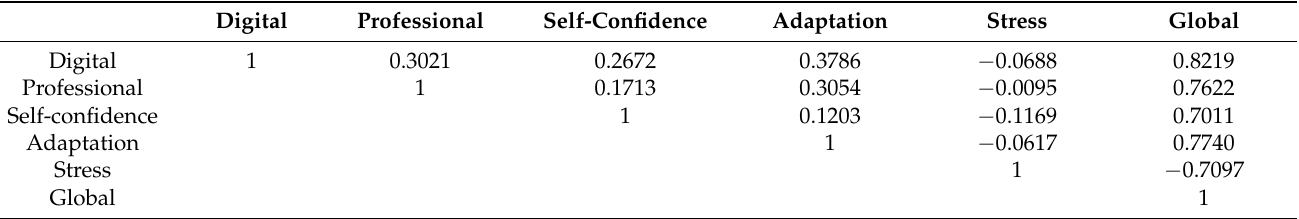
Table 6. Pearson correlation of the subscales among themselves and with respect to the global scale.